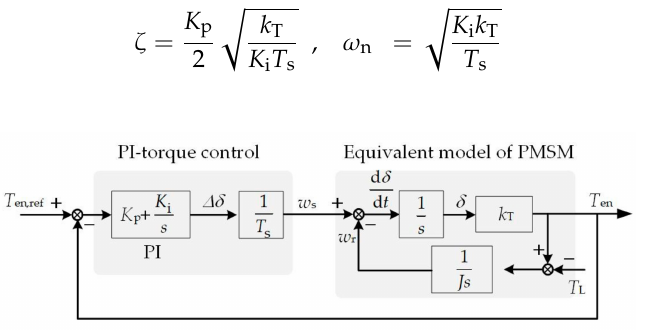
Figure 2. The control block of the torque loop.